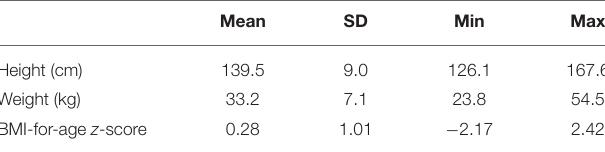
Oui/ Yes Coded as 1